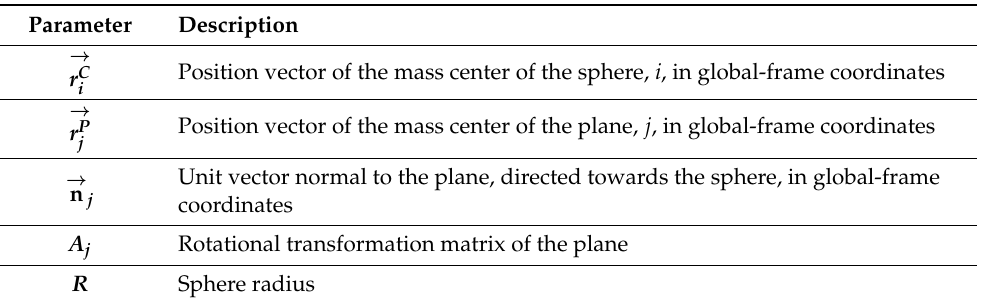
Figure 3. Calculation of the projection of the center of the sphere on the plane, Table 1. Summary of the parameters required to calculate the indentation between a sphere and an infinite